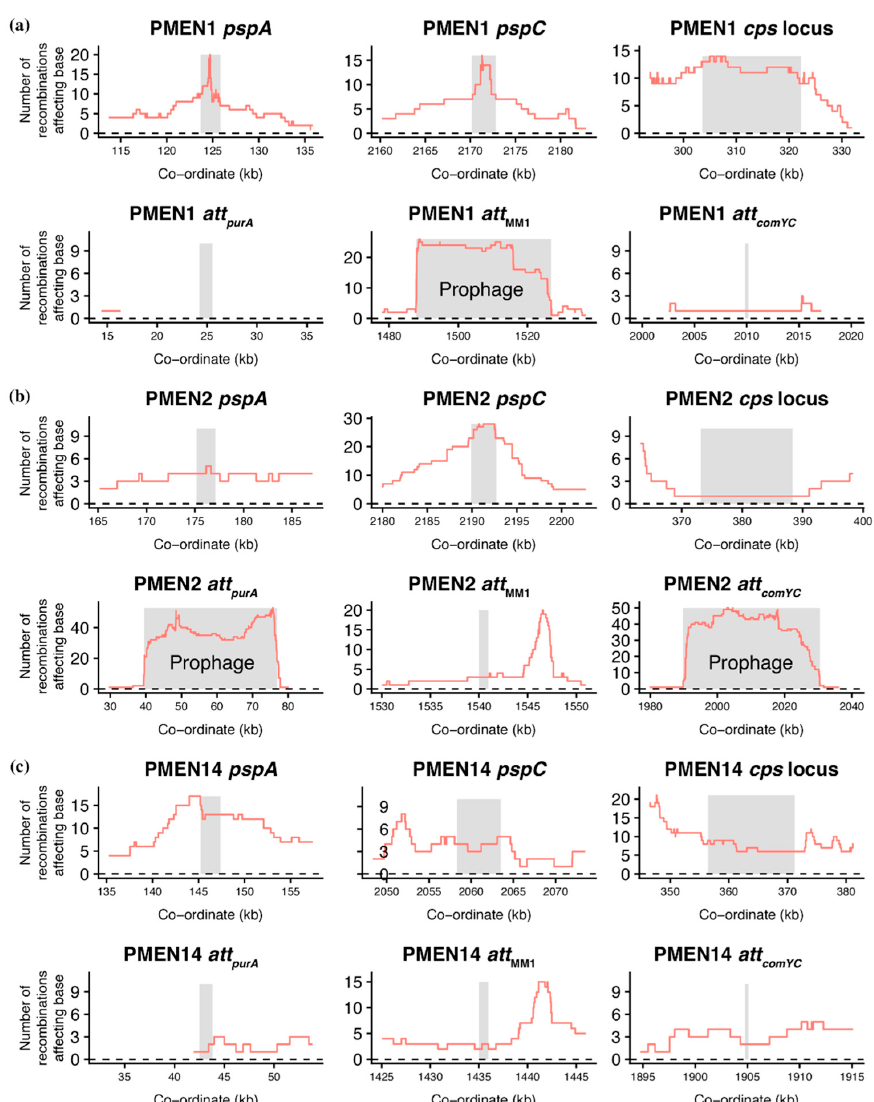
Figure 2. Distribution of recombinations importing sequence diversity at variable loci. These graphs use the outputs of Gubbins, which reconstructs the evolutionary diversification of strains through identifying recombinations and excluding these regions from the set of polymorphisms used for phylogeny generation. Data are shown from the analyses of reference-based alignments for the S. pneumoniae strains ( a ) PMEN1, ( b ) PMEN2, and ( c ) PMEN14. The horizontal axes are labelled with the genome co-ordinates in the relevant reference sequence used to generate the alignments. For each, the top row shows three genomic regions around the loci encoding antigenic structures: pneumococcal surface proteins PspA and PspC, and the capsule polysaccharide synthesis ( cps ) locus. In each plot, the grey stripe indicates the coding sequence, or sequences, that encode the antigens. Where inferred recombinations were detected within the regions, the red line shows the number spanning each base. The bottom row for each strain shows genomic regions encompassing the insertion, or att , sites for prophage. Two flank purA ( att purA ); one was identified as the insertion side of φ MM1 ( att MM1 ), and a fourth is within comYC ( att comYC ). Where prophage were present in the reference sequences (at att MM1 in PMEN1, and at att purA and att comYC in PMEN2), the grey stripe extends across their entire length of the MGE; otherwise a coding sequence flanking the att site is indicated by the stripe. The red lines again indicate the density of recombination events. The peak on the right in the att MM1 plots corresponds to the gene encoding dihydrofolate reductase, the alteration of which can cause trimethoprim resistance.